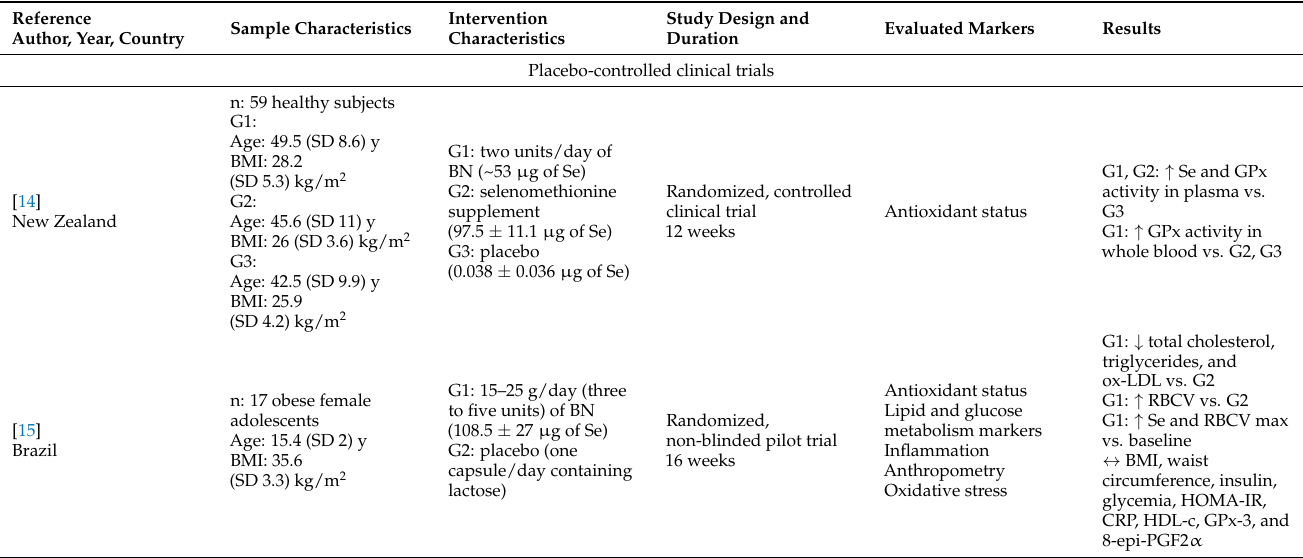
Figure 1. Flowchart of studies included in the systematic review. Table 1. Randomized clinical trials evaluating the effects of Brazil nut consumption on human health ( n =